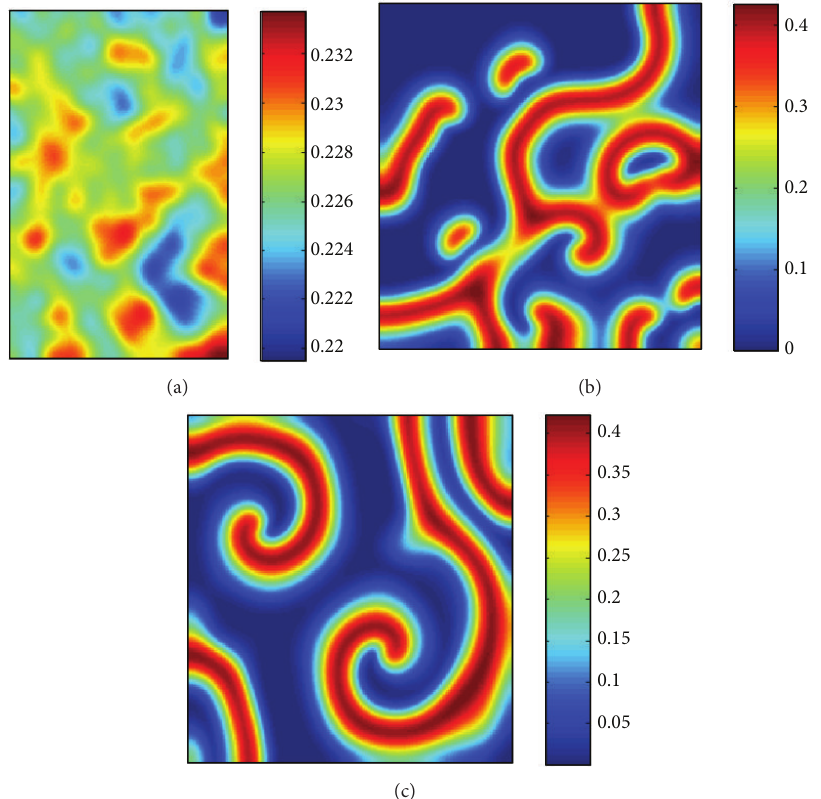
Figure 10: Snapshots of contour pictures of the time evolution of predator in system (3) when 𝑑 2 = 2 and 𝛿 = 0.15 < 𝛿 𝑤 : (a) 5000 iterations, (b) 150000 iterations, and (c) 200000